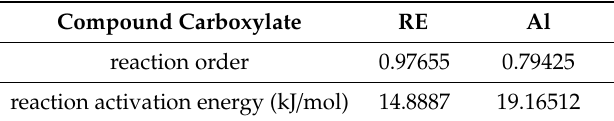
Figure 13. The relationship between ln k and 1 / T . Table 5. Leaching reaction order and activation energy of RE and Al with compound ammonium